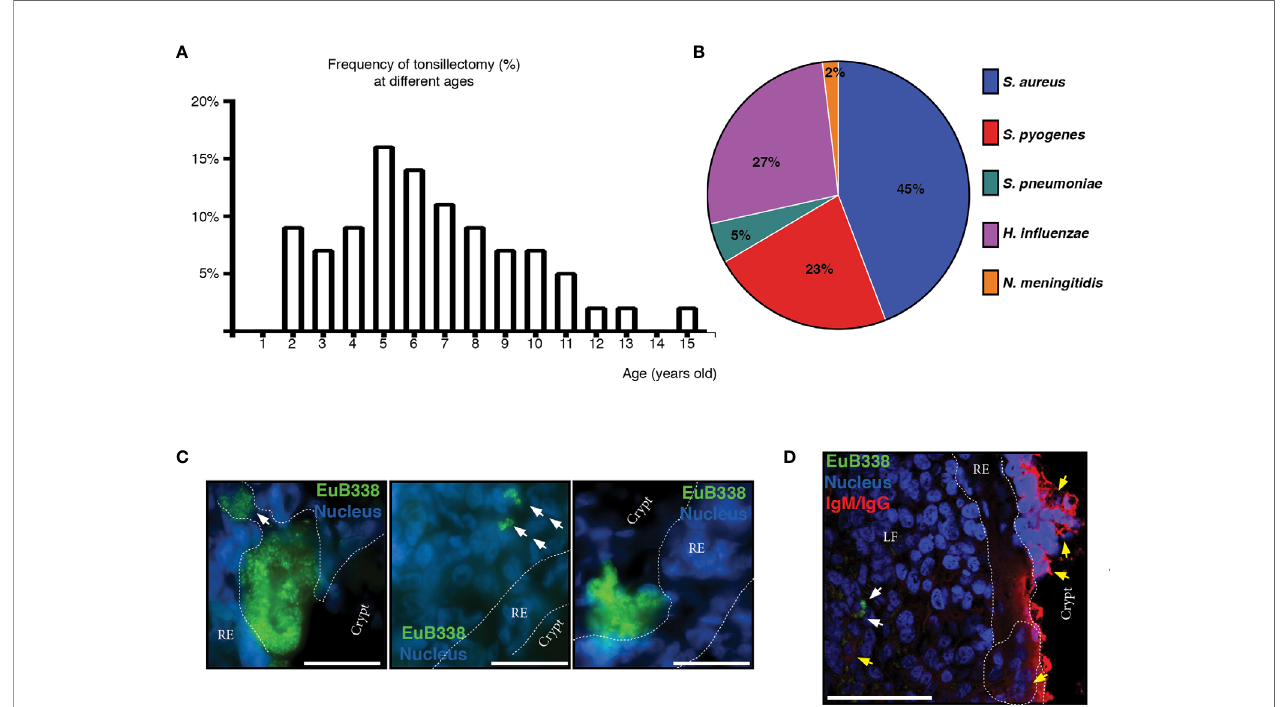
FIGURE 5 | Microbiological aspects of hypertrophic tonsils. (A) Age distribution of patients who had tonsillectomy due to OSA. (B) The graph shows the frequency of potential pathogenic bacterial detection in tonsils. (C) Microphotographs of the bacterial aggregates in tonsillar frozen sections from different OSA patients evidenced by fl uorescence in situ hybridization (FISH) with a general eubacterial probe (EUB338-Alexa 488, green). Host cells nuclei were stained with DAPI (blue). Dashed line represents the limits of the reticular epithelium (RE) on both margins. White arrows indicate the conglomerates of bacteria that have penetrated the epithelial barrier. Scale bar, 50 µm. Samples were examined with a Nikon Eclipse Ti-E microscope. (D) Three-color immuno fl uorescent confocal microscopy of tonsillar frozen sections. Bacterial aggregates in tonsillar frozen sections were evidenced as in (C) and are indicated with white arrows. Yellow arrows indicate B and plasma cells. Dashed line represents the limits of the reticular epithelium (RE) on both margins. Clusters of B/plasma cells are enclosed by dashed lines. LF stands for Lymphoid Follicle. Scale bar, 50 µm. Samples were examined with an Olympus FV 1000 confocal